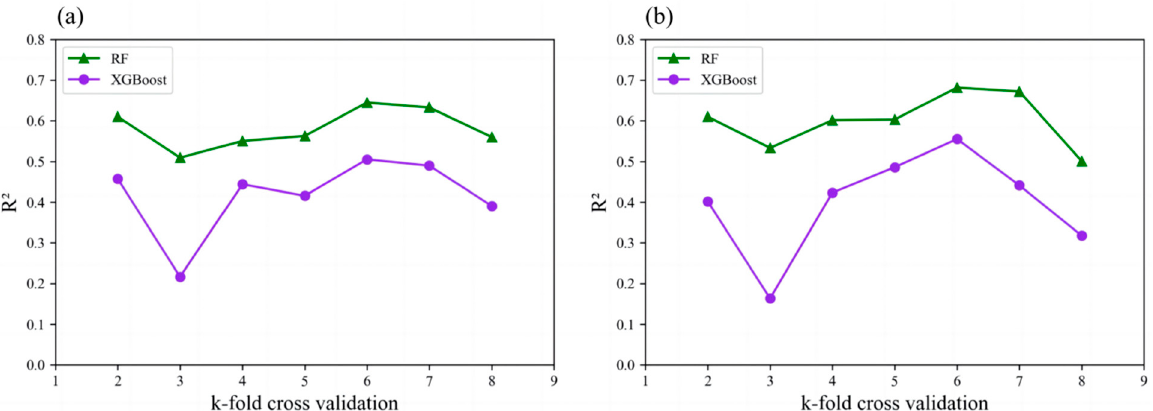
Figure 4. Model accuracy under k -fold cross validation with commonly used variables ( a ) and com- monly used variables and phenological variables ( b ). commonly used variables and phenological variables ( b